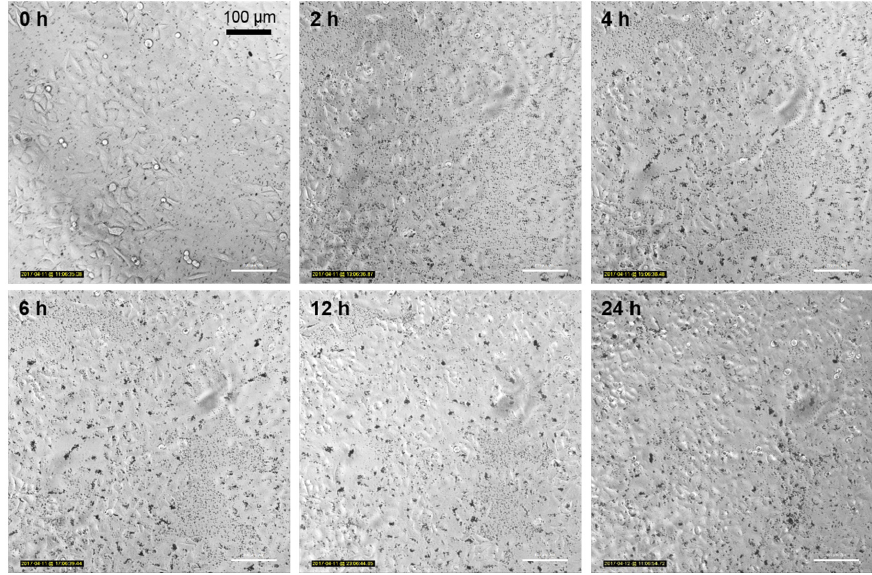
Figure 6. Time ‐ lapse microscopic imaging of A549 cells incubated with 12.5 μ g mL − 1 FITC ‐ TiO 2 NPs for 24 h. Magnification 20×. for 24 h. Magnification 20 × . Toxics 2017 , 5 , 15